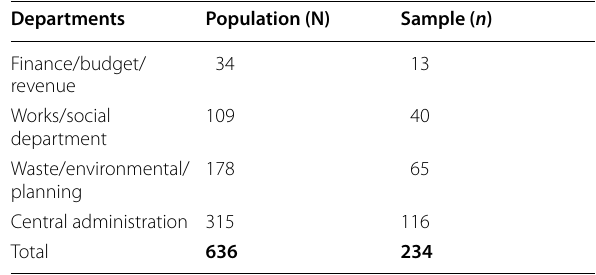
Table 3 Summary of Study